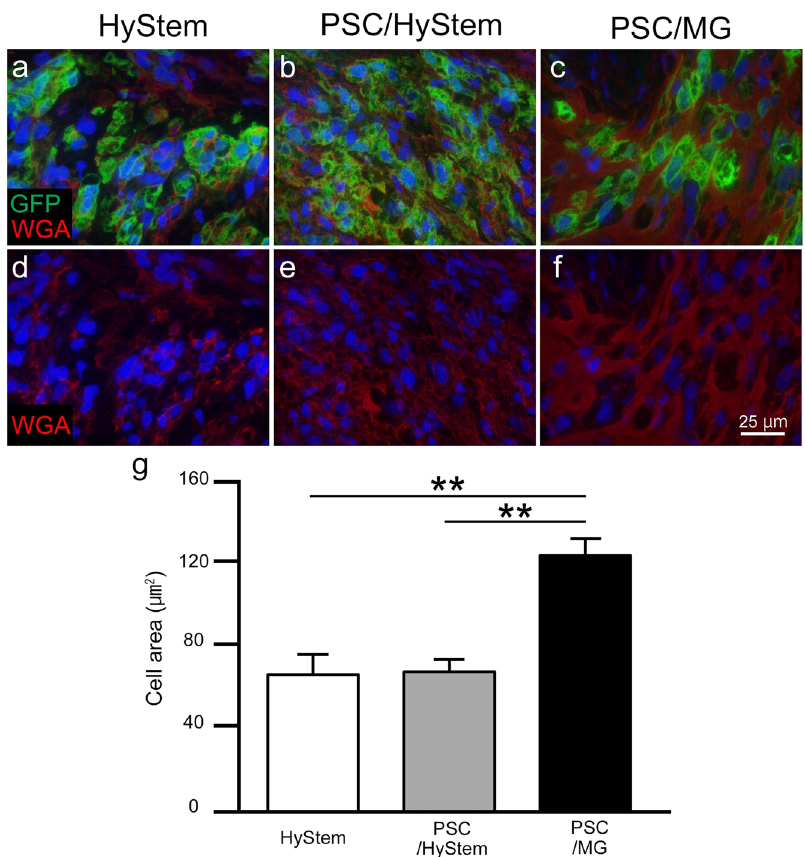
Figure 4. The PSC/MG group shows the largest graft cardiomyocytes in size. ( a – f ) Representative images of the graft area stained with GFP and wheat germ agglutinin. ( g ) Graft cell area, ** P < 0.01. PSC, pro-survival cocktail; MG, Matrigel; GFP, green fluorescent